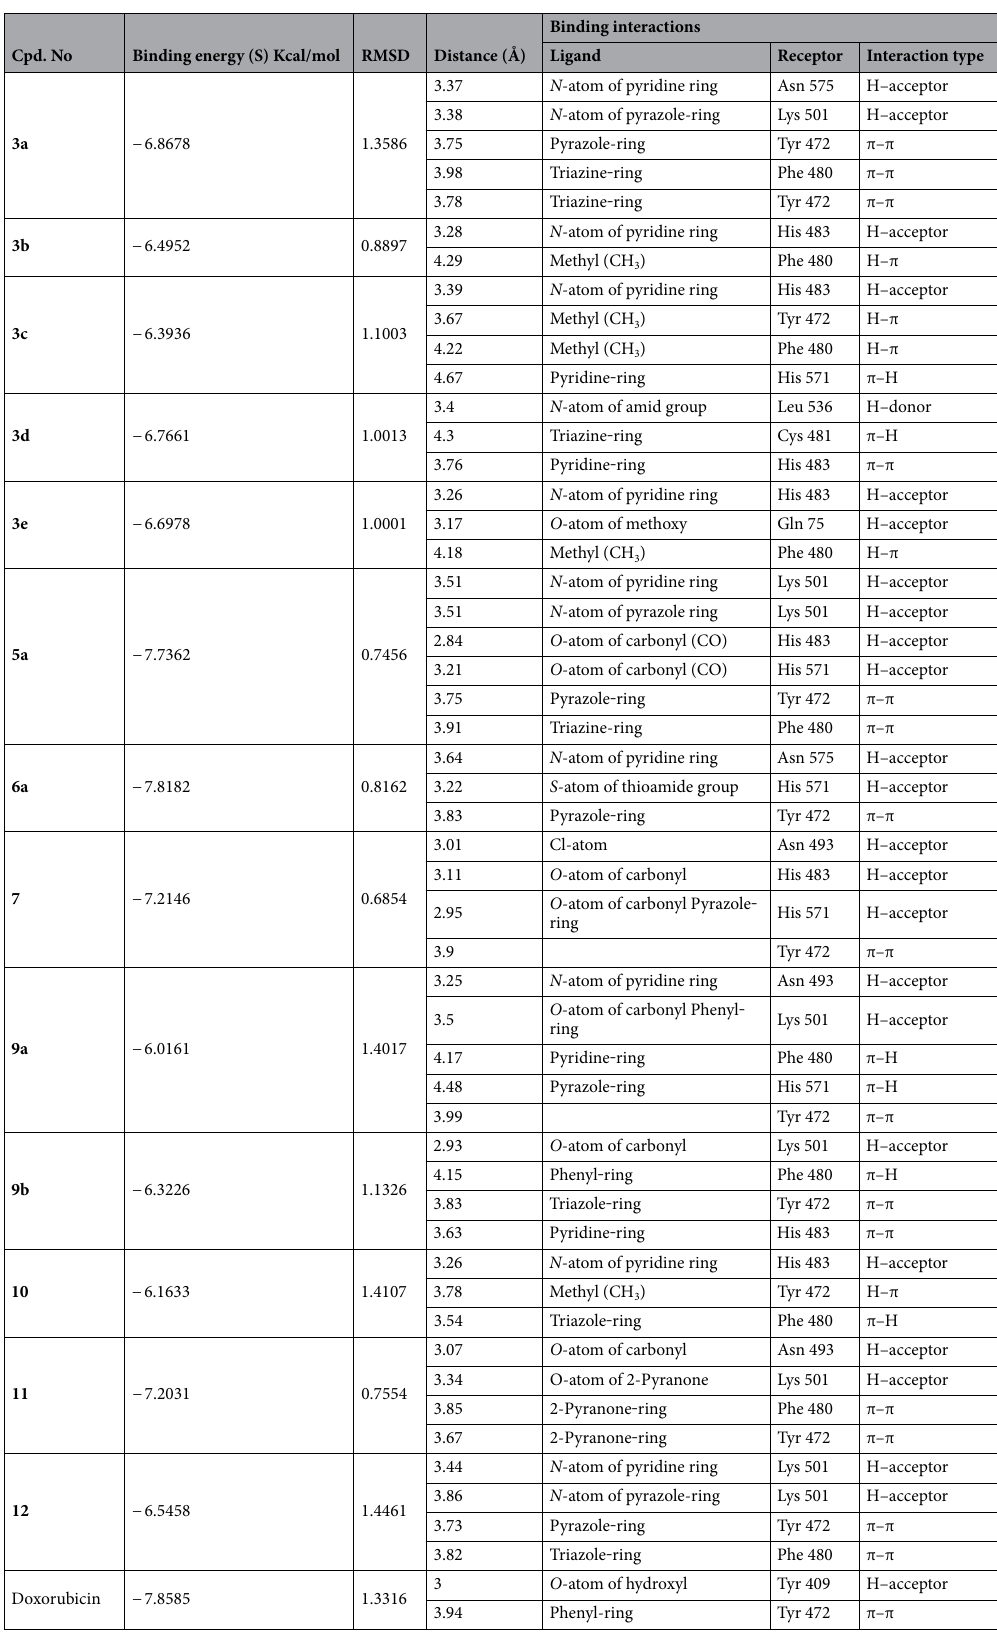
Table 2. Predictive docking scores and particular interactions of the ligands and the